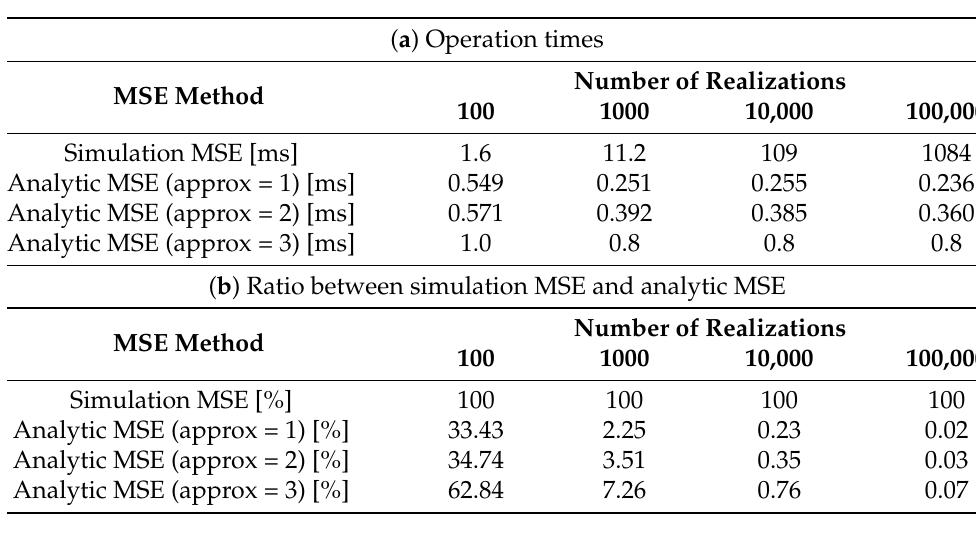
Table 6. Comparison of operation